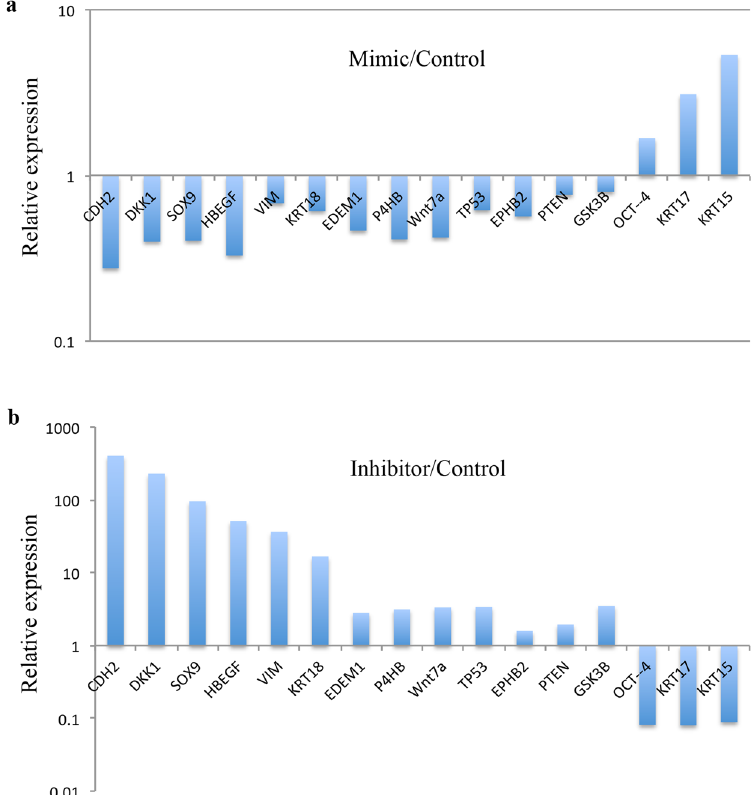
Figure 6. miRNA Profiling of miR-10b Transfected HCEC by Fluidigm QPCR. Transfection with miR-10b mimic using RNAiMax decreased significantly the mRNA expression level of some putative LESC markers and miR-10b predicted targets ( a ). Transfection with miR-10b inhibitor significantly increased their expression levels ( b ) in HCEC compared to their corresponding scrambled sequence controls (mimic control and inhibitor control, respectively). Further, the putative LESC marker mRNA levels that were increased in HCEC transfected with miR-10b, showed decreased levels in HCEC transfected with miR-10b inhibitor in comparison to corresponding controls. Student’s t-test P <